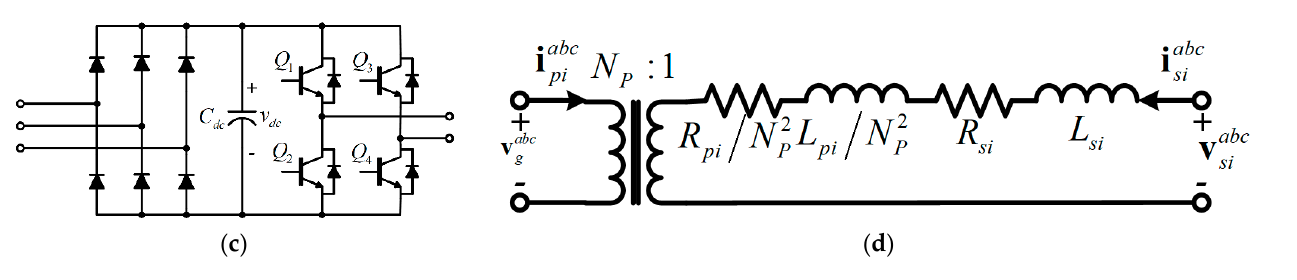
Figure 1. ( a ) AC drive based on CHB, ( b ) traditional power cell for AC drive based on CHB, ( c ) proposed topology, ( d ) wye–wye input transformer model referred to the secondary